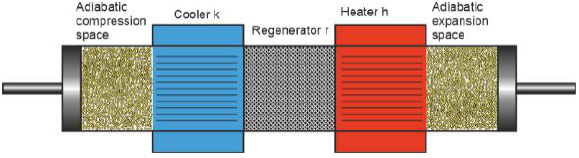
Fig. 10. Scheme of workspaces for adiabatic model [22]